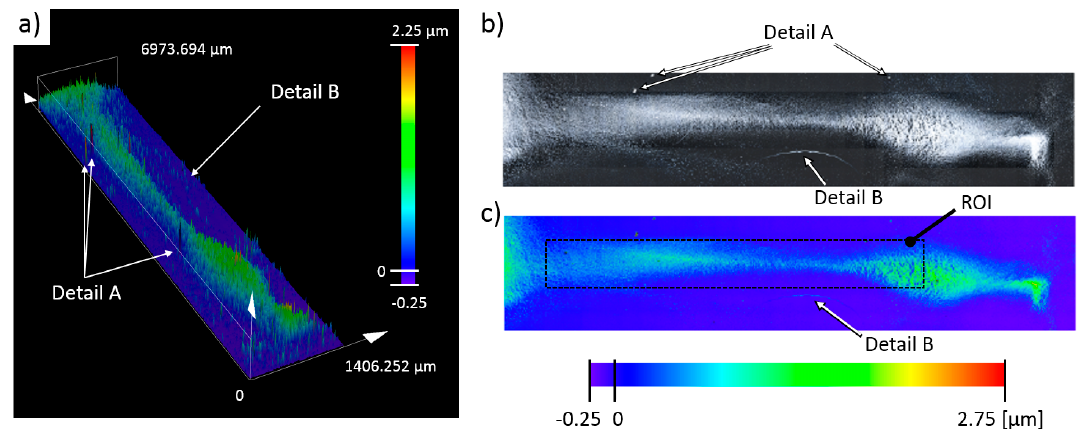
Figure 17. Three-dimensional (3D) scan results of the prepared sample. ( a ) 3D scan of the obtained deposit height. The color bar in the panel denotes the computed height of the whole sample; ( b ) 2D intensity image of the scanned sample; ( c ) 2D height color image of the scanned sample. ROI indicates the region of interest used for quantification of aerial roughness parameters.